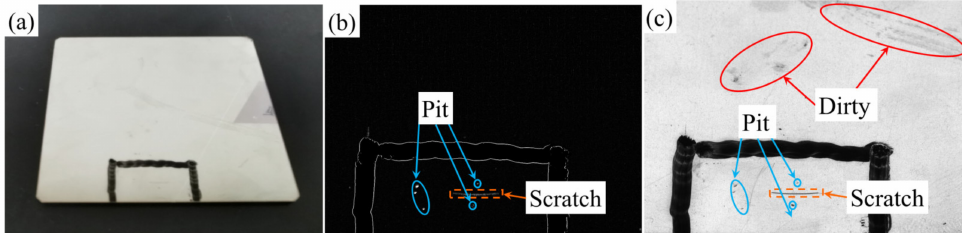
Figure 7. Polished metal plate ( a ), test results ( b ) and bright field image ( c ).